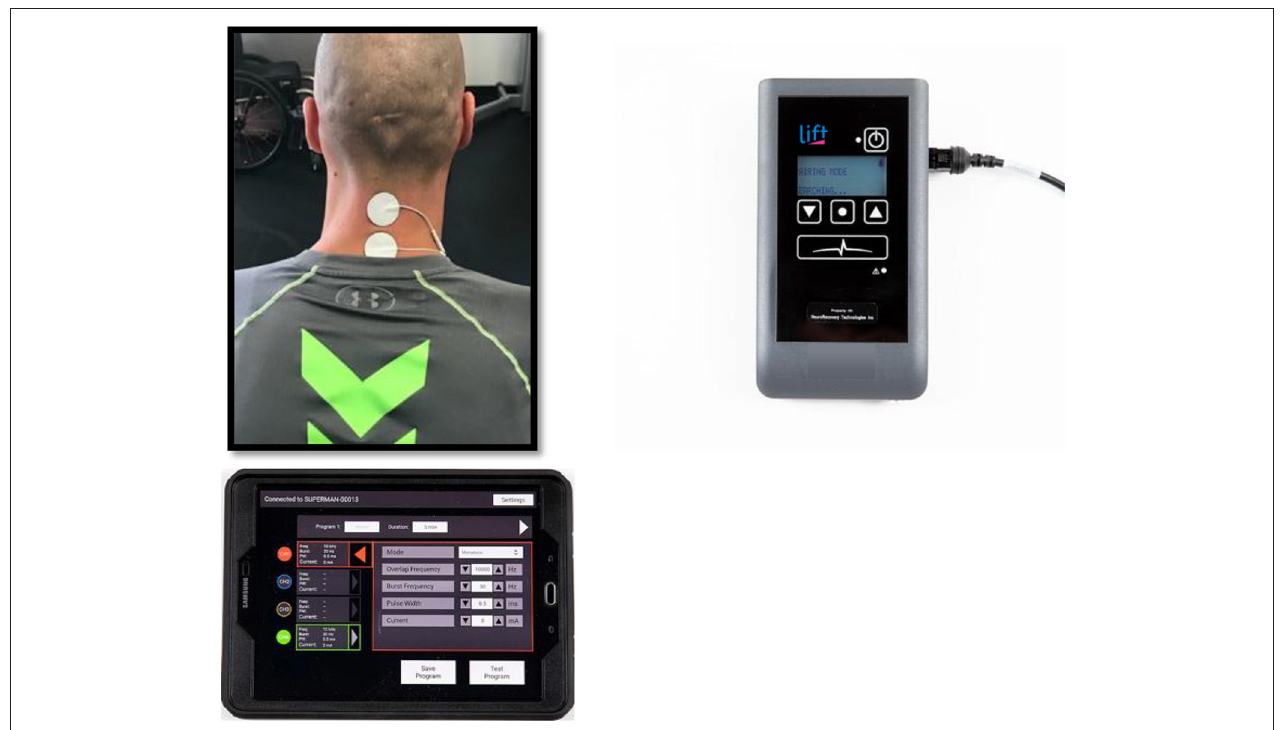
FIGURE 1 | Transcutaneous electrical spinal cord stimulation set up at the cervical spine for one representative participant. adjusted to a level that provided optimal functional movement for that specific